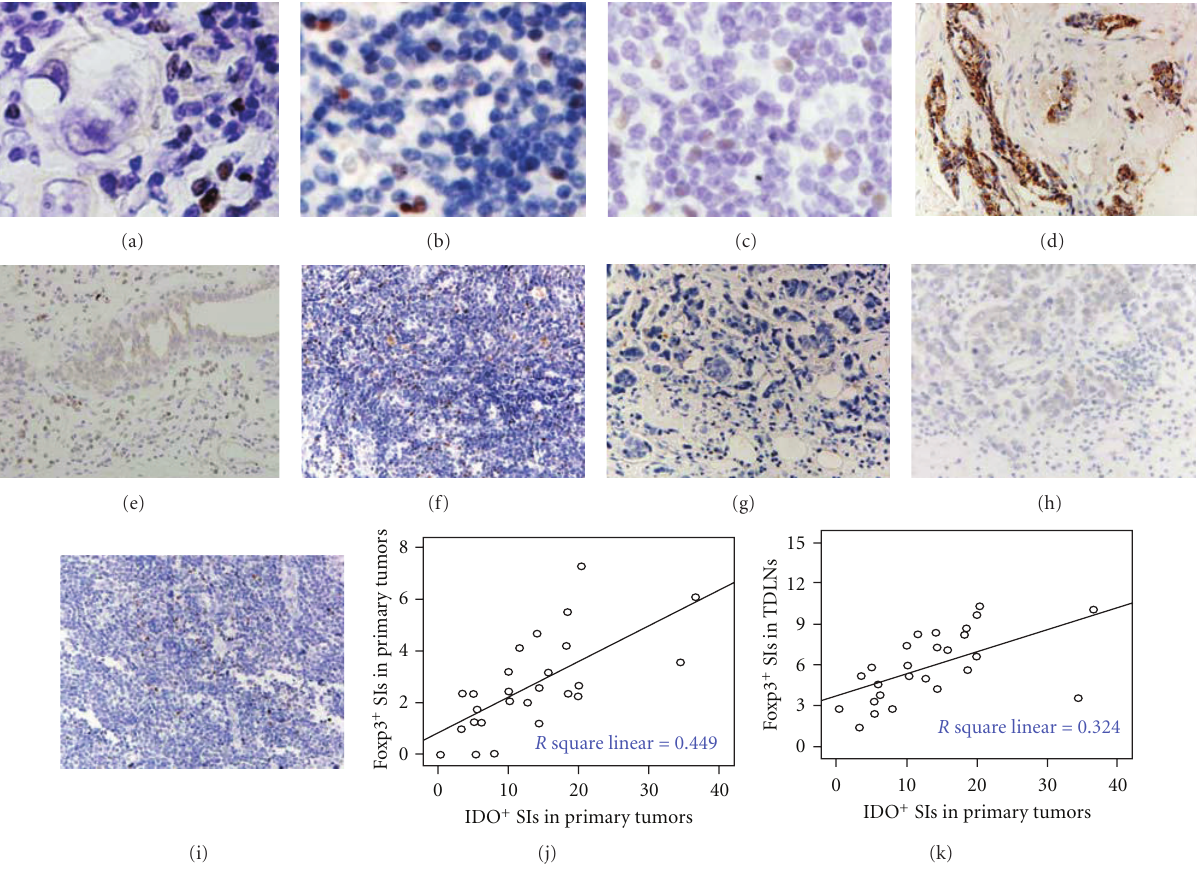
Figure 2: IDO expression in PTs was positively correlated with the density of Tregs in PTs and TDLNs. The Foxp3 + Tregs in PTs, TDLNs, benign disease, and normal adjacent tissues were detected using IHC staining method. (a)–(c) The Foxp3 protein appeared in the nuclei of lymphocytes infiltrated into PTs (a) and TDLNs, including nonmetastatic TDLNs (b) and metastatic TDLNs (c). (d)–(i) In the PTs with higher expression of IDO (d), more Foxp3 + Tregs infiltrated into the PTs (e) and corresponding TDLNs (f). In contrast, in the PTs with lower or no expression of IDO (g), less Foxp3 + Tregs were detected in the PTs (h) and corresponding TDLNs (i). (j) and (k) Scatter plots were generated to display the correlation between IDO expression in breast cancer (IDO + SIs in primary tumors) and the density of Foxp3 + Tregs in PTs (Foxp3 + SIs in primary tumors) or in TDLNs (Foxp3 + SIs in TDLNs). The IDO + SIs displayed a positive correlation with the Foxp3 + SIs in PTs with a linear regression equation of Y = 0.832 + 0.140 X (j). Accordingly, the IDO + SIs showed a similarly positive correlation with the Foxp3 + SIs in TDLNs with a linear regression equation of Y = 3.771 + 0.160 X